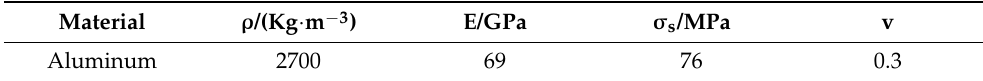
Figure 3. The model of simulation. Table 1. Mechanical properties of the aluminum. Table 1. Mechanical properties of the